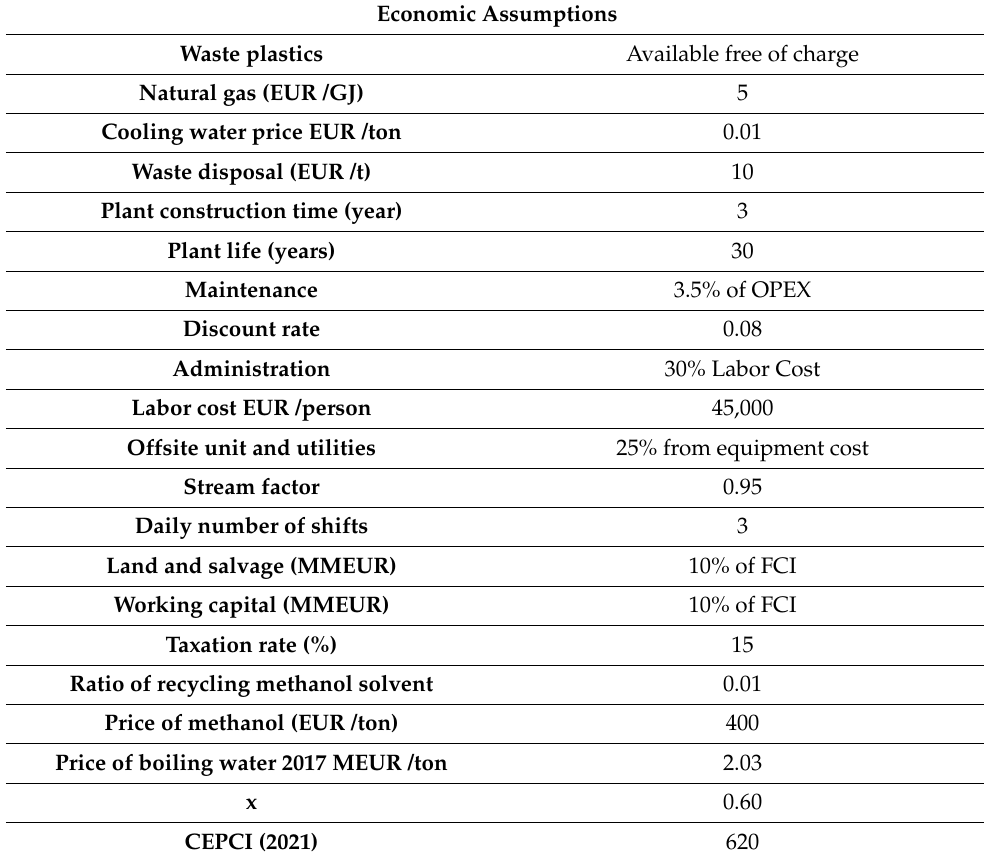
Table A3. The assumptions for economic